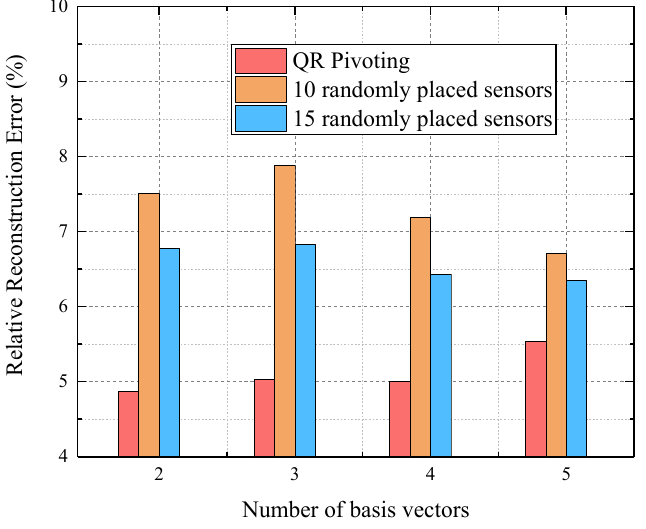
Figure 28. Reconstruction errors with different numbers of basis vectors.